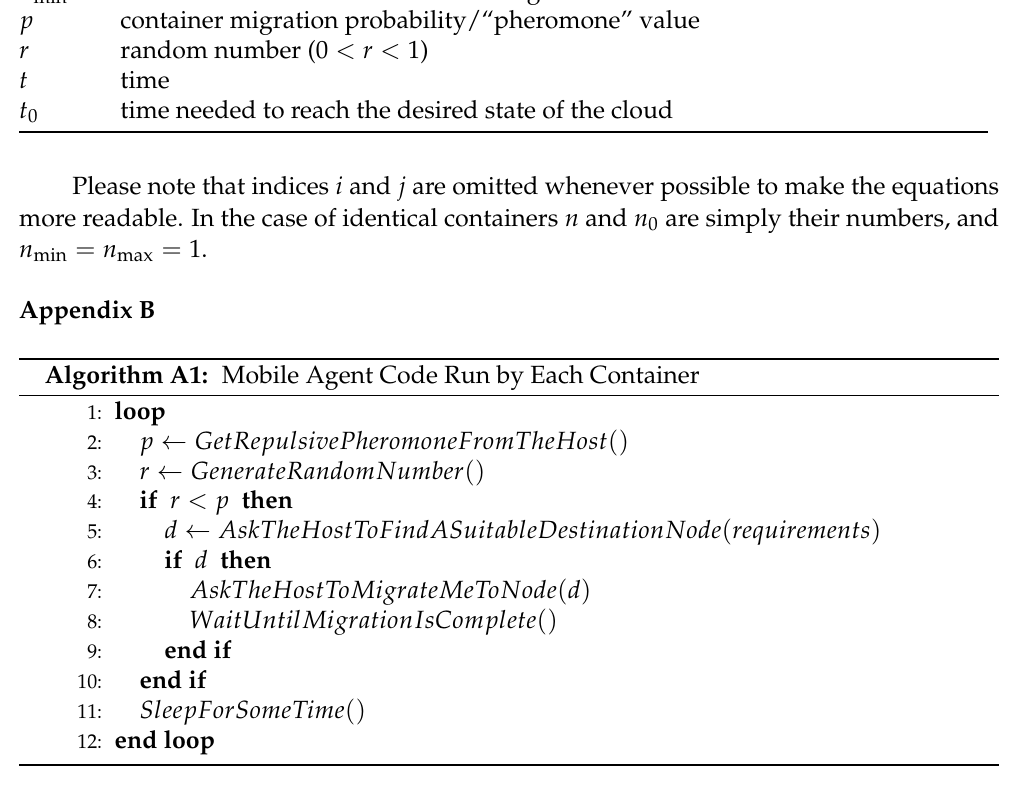
Table A1. Cont . n 0 dominant/least dominant resource capacity of a node ( k ) n capacity of a node corresponding to resources of a given kind 0 n max maximal dominant/least dominant resource usage from all containers on a node n min minimal least dominant resource usage from all containers on a node p container migration probability/“pheromone” value r random number (0 < r < 1) t time t 0